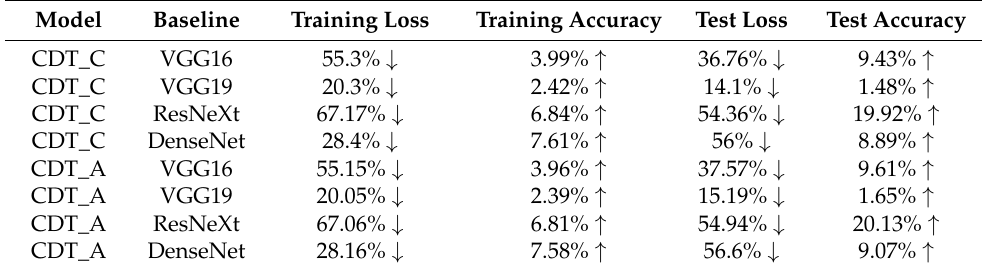
Table 1. Specific compared results on CIFAR-10.